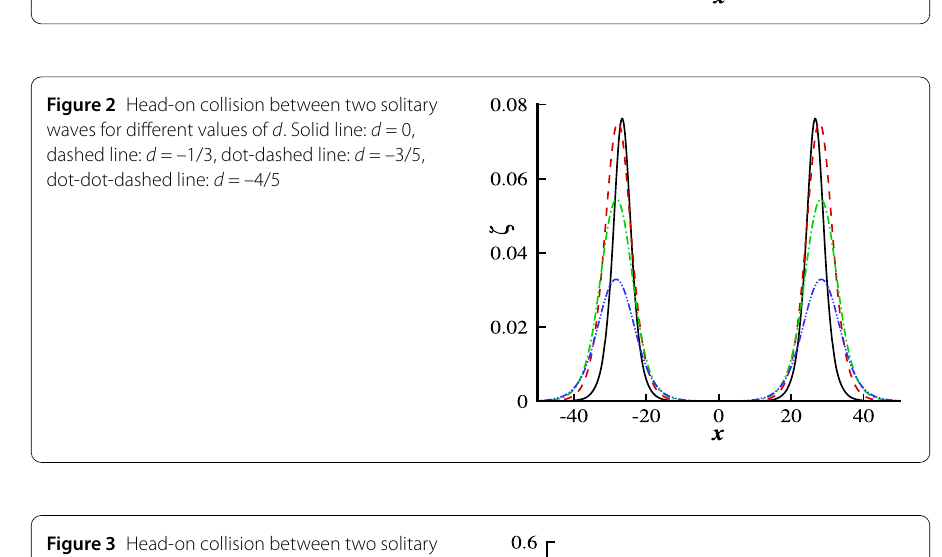
Figure 3 Head-on collision between two solitary waves for different values of h . Solid line: h = 1, dashed line: h = 3, dot-dashed line: h = 5, dot-dot-dashed line: h =